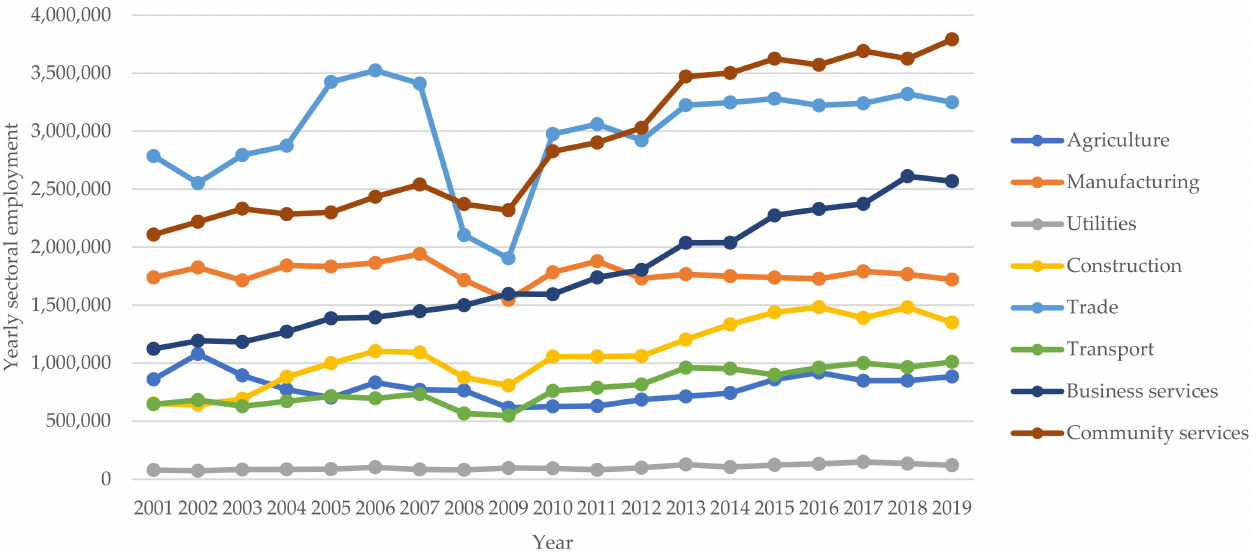
Figure 2. Sectoral employment in South Africa (excludes mining, private households).